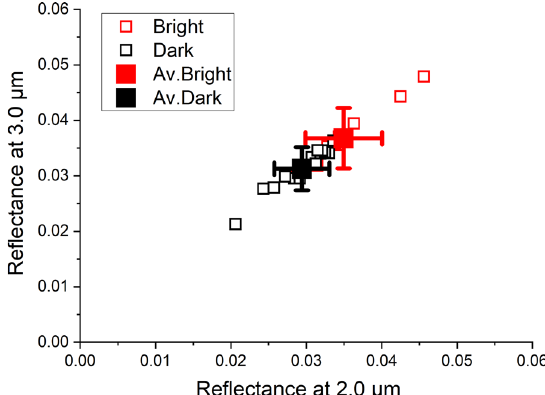
Fig. 10 Comparison of reflectance between bright and dark group. Reflectance at 2.0 and 3.0 μm of bright and dark group grains obtained by